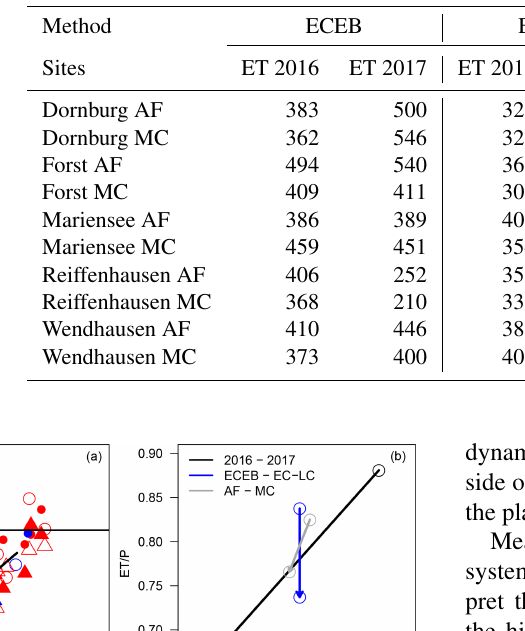
Table 6. Annual sums of energy balance closure corrected actual evapotranspiration, ET (mma − 1 ), and precipitation, P (mma − 1 ) for all sites, both set-ups (ECEB and EC-LC), and both years (April to December 2016; January to December 2017). The annual sums of ET ECEB and precipitation at Reiffenhausen AF and MC in 2017 contain data from 1 January to 1 July 2017 due to the destruction of the station. Annual sums of ET EC-LC for Dornburg AF and MC, Mariensee AF, and Reiffenhausen AF and MC in 2017 are missing due to instrument malfunctions.